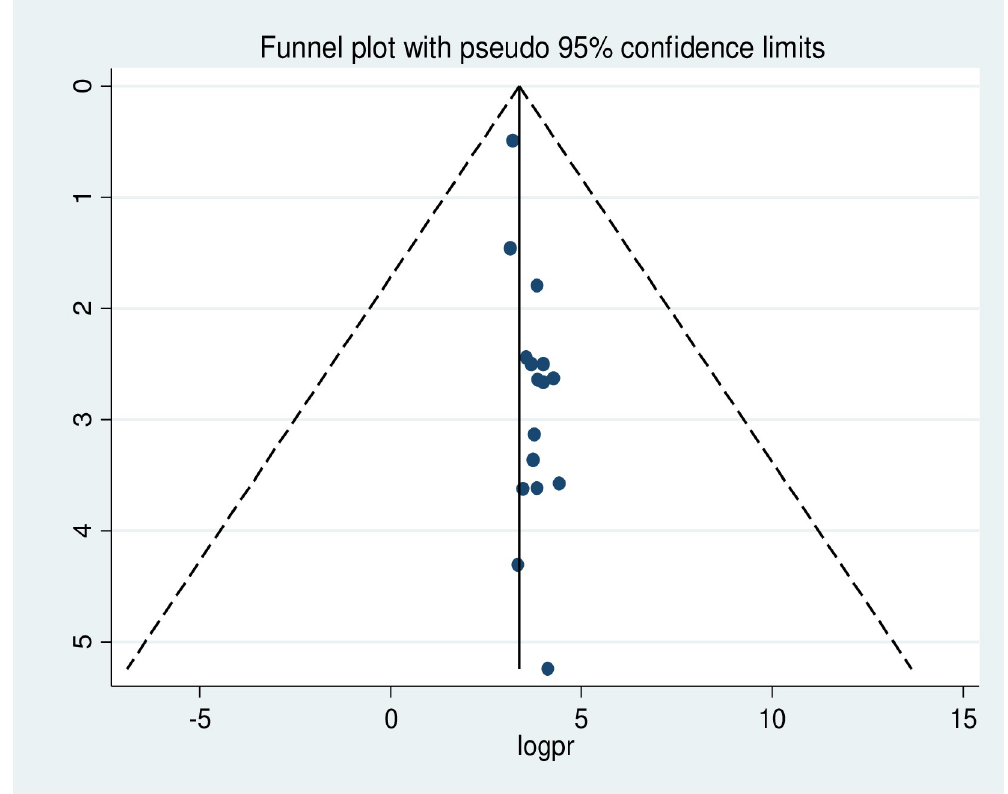
Fig 7. Funnel plot showing asymmetrical distribution of studies indicating the presence of publication bias. The Y-axis is the standard error and the X-axis is the study result or effect size. The dotted diagonal line of the funnel is the 95% confidence interval and the vertical. The vertical line is the line of no-effect and dots are included studies reporting attitude of kangaroo mother care.